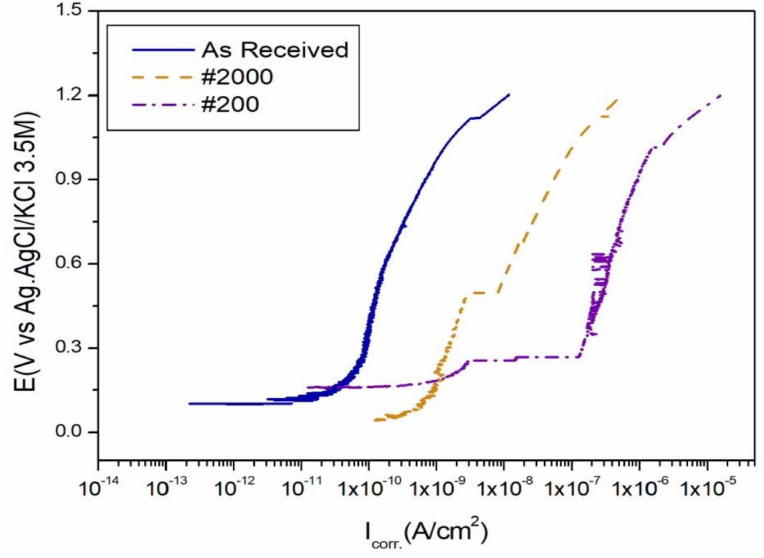
Figure 2. Corrosion current density of CFRP during potentiodynamic corrosion testing with a 5.0 wt.% NaCl aqueous solution